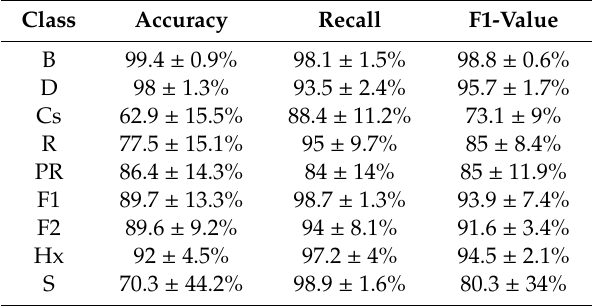
Table 1. Classification results over the validation set.